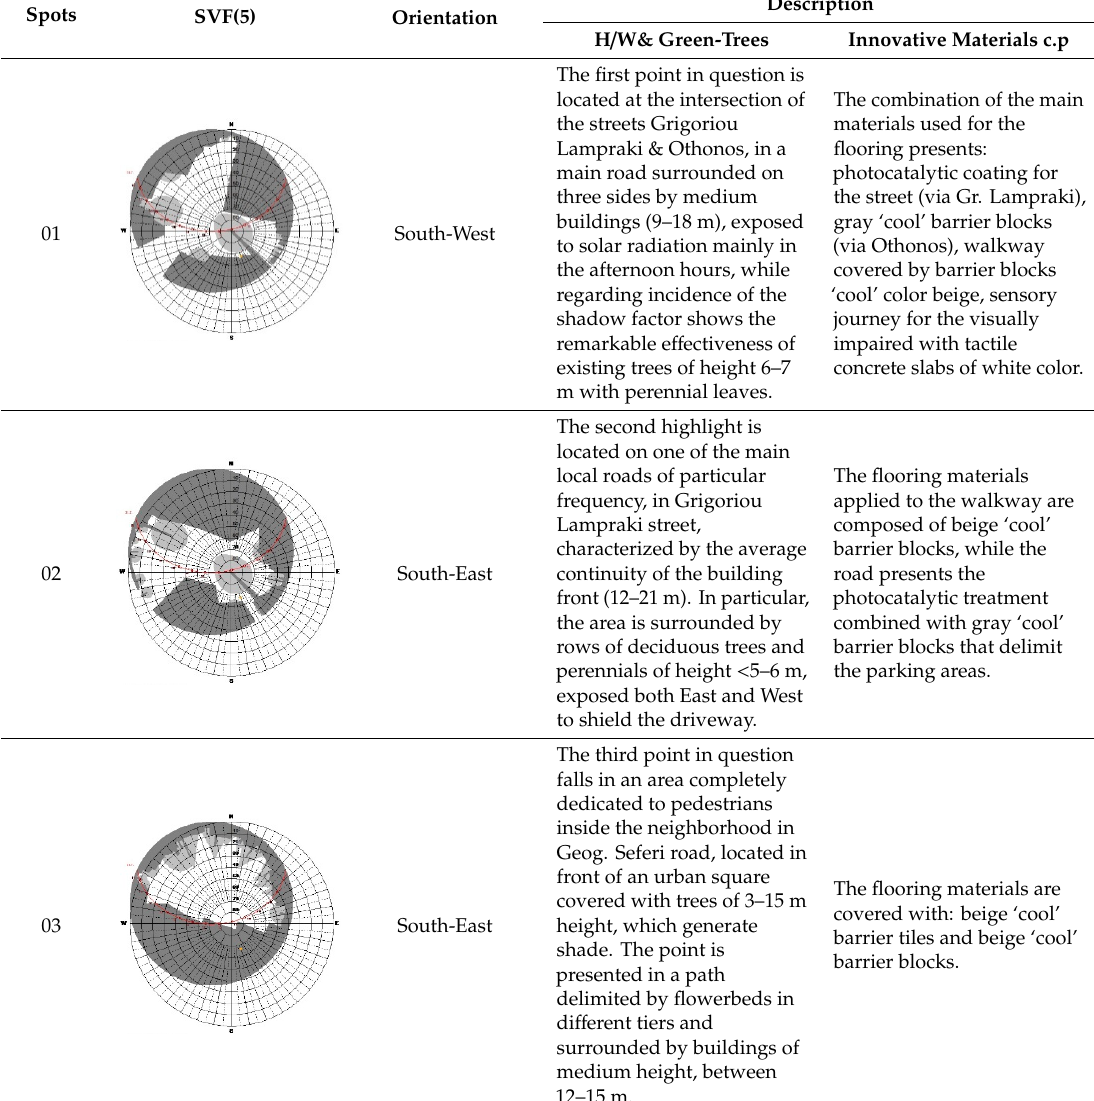
Green-trees : Trees according to the size, type and distribution are able to intercept solar radiation (shading), and also decrease the air temperature (evapotranspiration). The present case study consists of a percentage of approximately 63% of deciduous types for an average size <12–18m with a predominantly linear distribution. Table 3. Spatial configuration of the urban canopy of the eleven spots. Innovative cool pavement materials: According to the radiant properties of the materials, the Table 3. Spatial configuration of the urban canopy of the eleven spots. reflectance ( α ) and emissivity ( ε ) of solar radiation are shown in Table 2. Table 3. Spatial configuration of the urban canopy of the eleven spots. Table 3. Spatial configuration of the urban canopy of the eleven